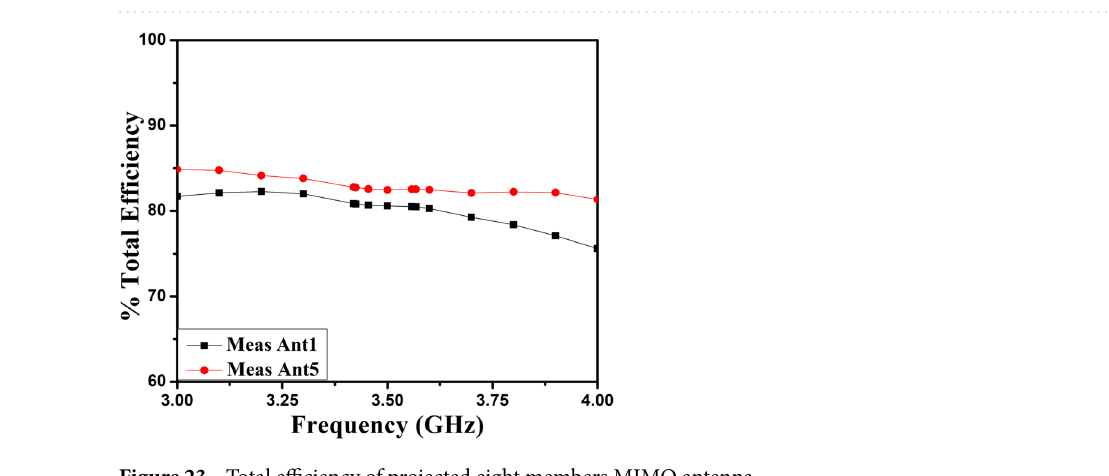
Figure 22. Proposed 8 Members MIMO antenna Polar plot ( a ) Ant 1 E-plane, ( b ) Ant1 H-plane, ( c ) Ant 5 E-plane, ( d ) Ant 5 H-plane.